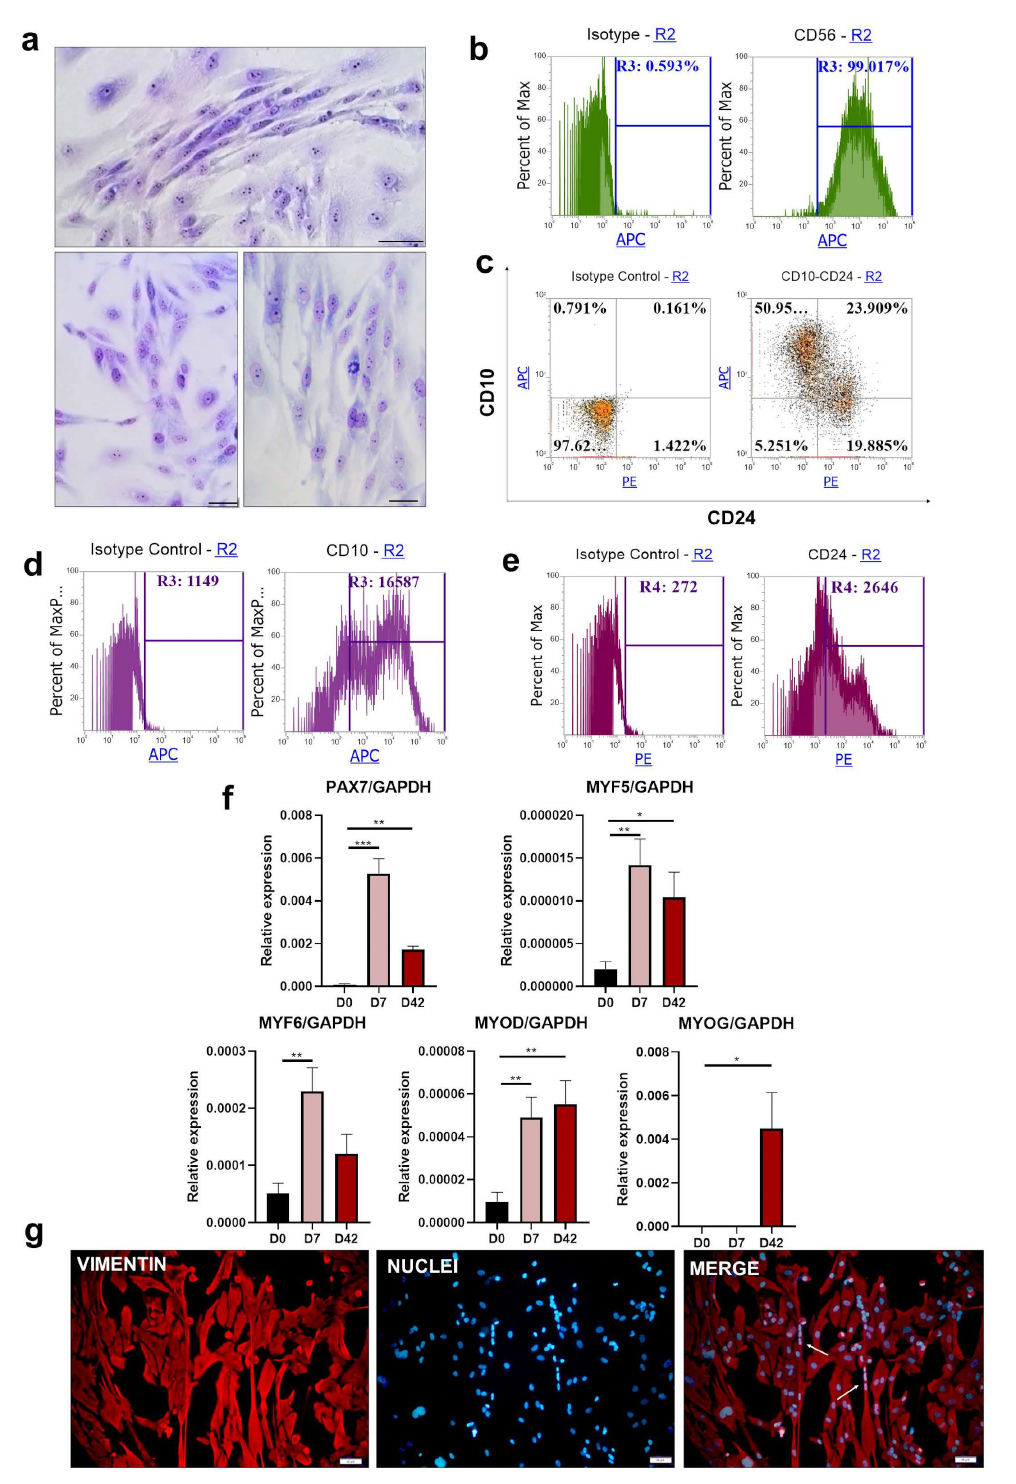
Figure 3. Differentiation of iPS cells into skeletal muscles with Protocol II: ( a ) morphology of the cells visualized with Wright’s staining on day 42 of the experiment. Scale bar represents 50 µ m. ( b ) representative results of flow cytometry analysis of CD56 expression on day 42; ( c ) double staining for CD10 and CD24 expression analyzed with flow cytometry on day 42, representative result; ( d ) analysis of the total CD10 + mean fluorescence intensity on day 42, representative result; ( e ) analysis of the total CD24 + mean fluorescence intensity on day 42, representative result; ( f ) qPCR analysis of myogenic genes expression during the differentiation, n = 3 or more 4, * p < 0.05, ** p < 0.01, *** p < 0.001; ( g ) vimentin and cell nucleus immunofluorescence staining at the end of the experiment. Scale bar represents 50 µ m; white arrows indicate cell